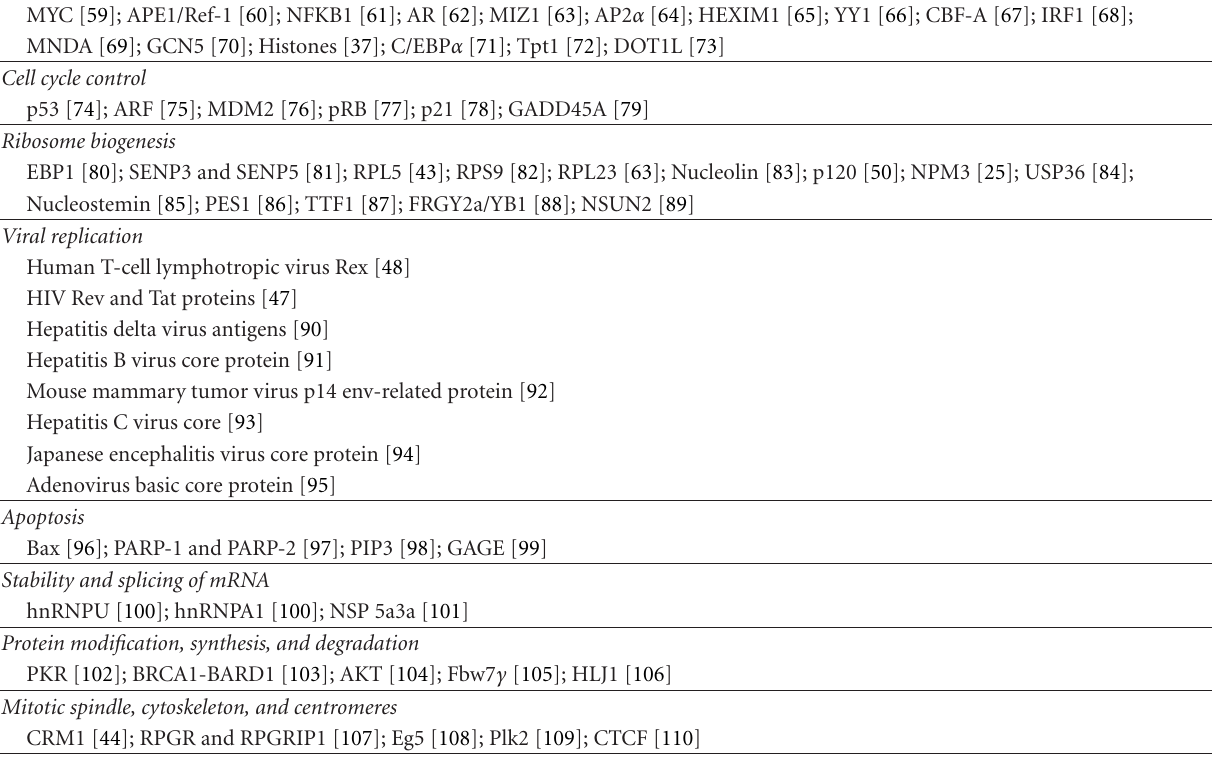
Table 1: NPM1 binding